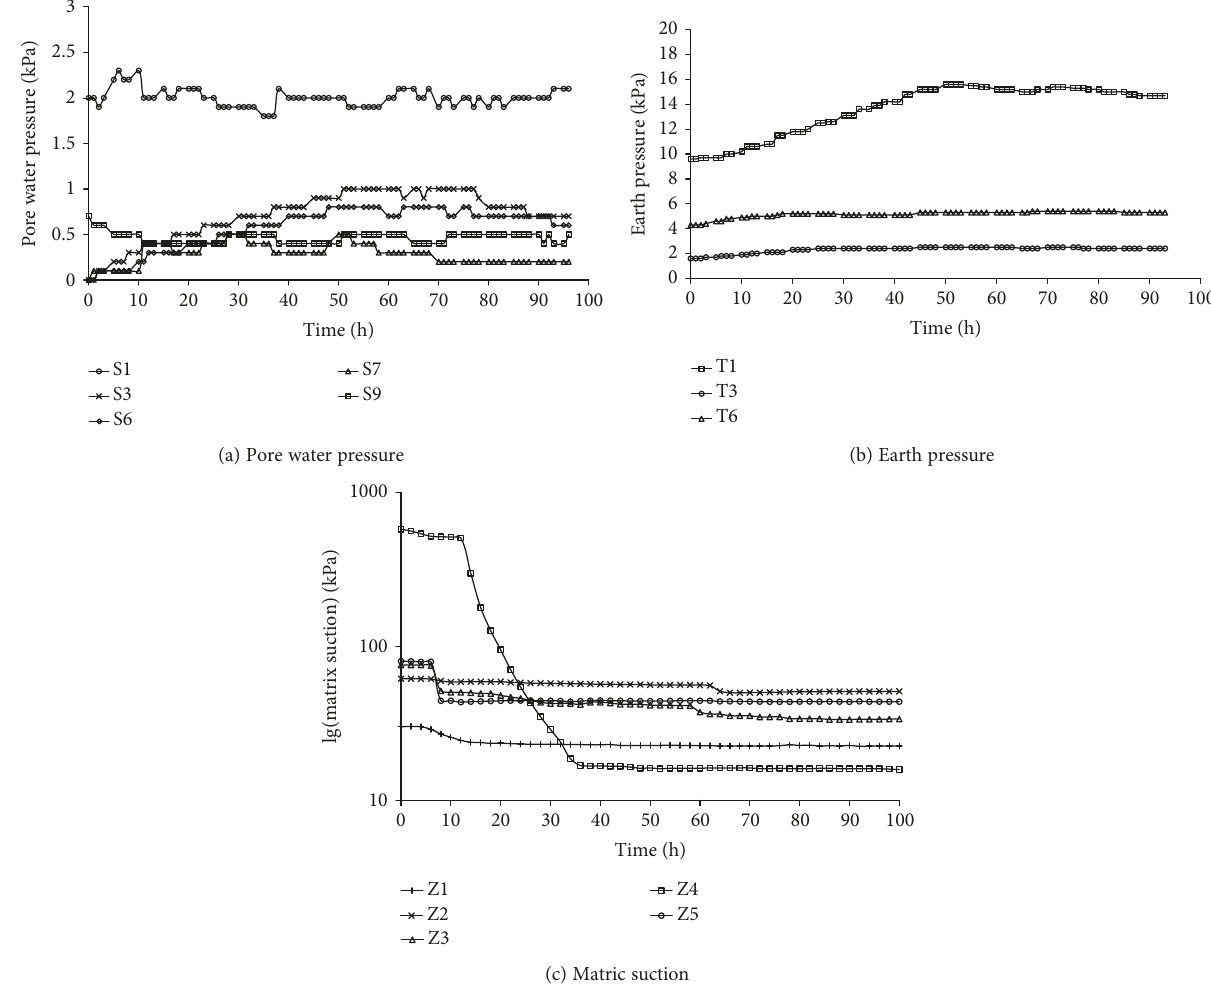
Figure 11: Results during the rainfall and fl ooding